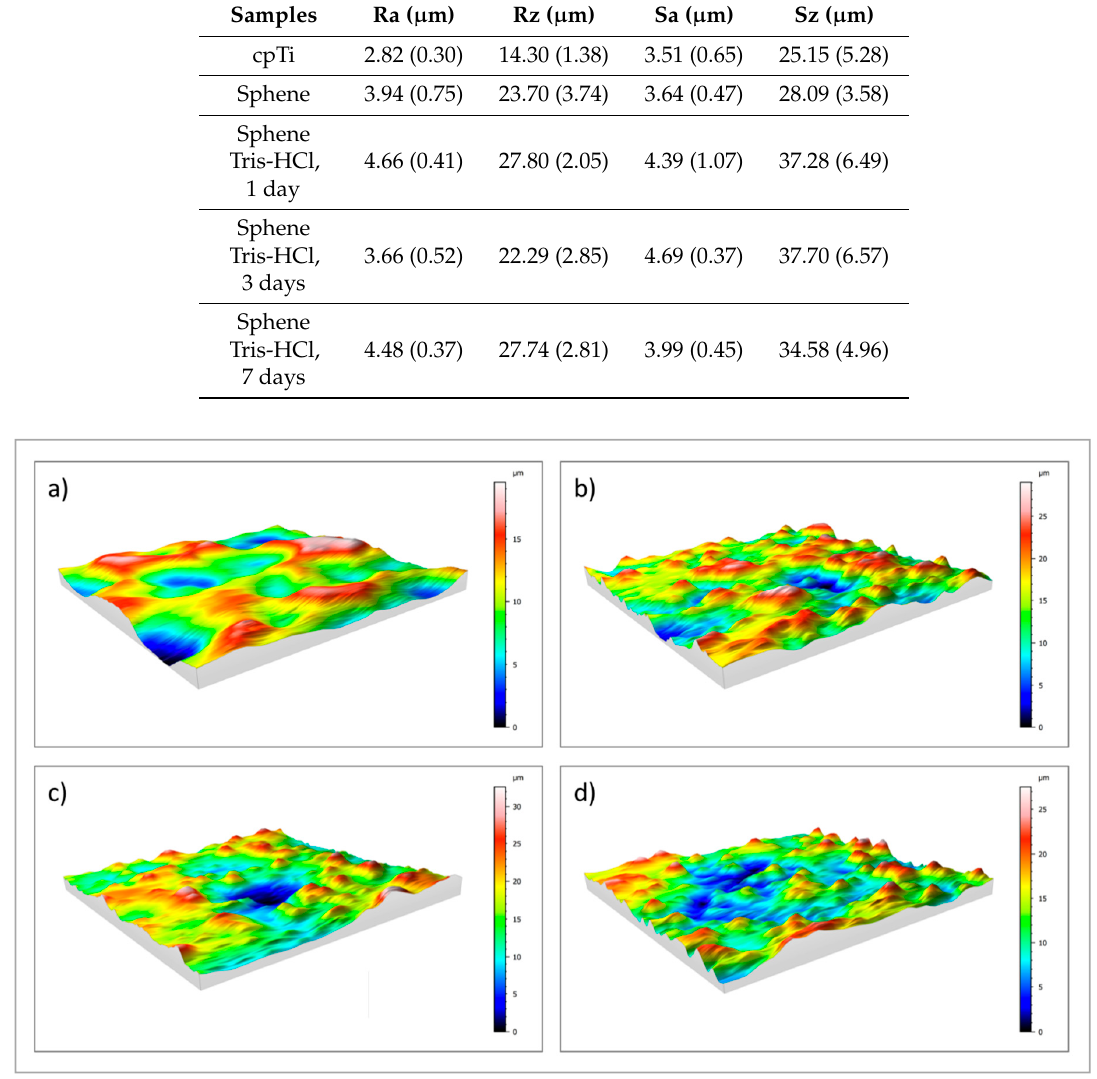
Figure 3. 3D maps of: ( a ) uncoated cpTi; ( b ) sphene-coated cpTi; ( c ) sphene-coated cpTi after 1 day in Tris-HCl buffer solution; ( d ) sphene-coated cpTi after 7 days in Tris-HCl buffer solution.